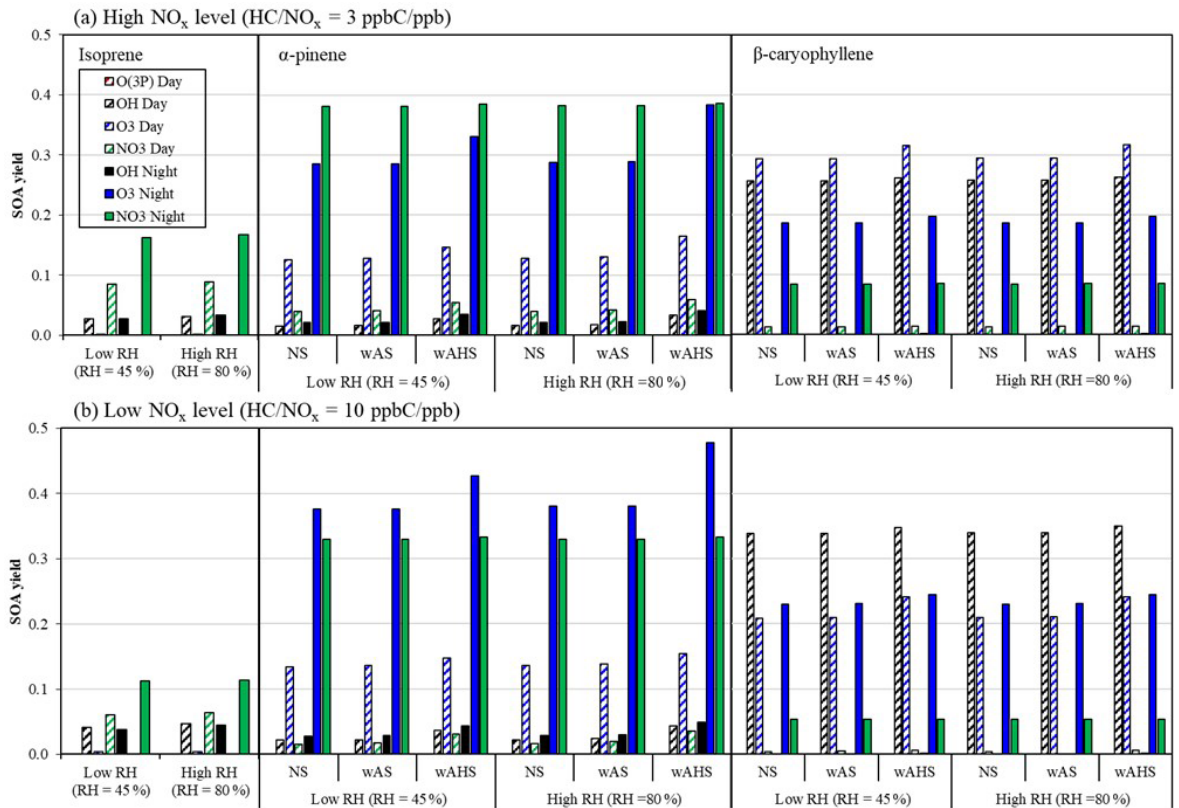
Figure 4. The simulated potential SOA yield from each oxidation path from the given HC consumption at a (a) high NO x level (HC / NO x = 3ppbCppb − 1 ) and (b) low NO x level (HC / NO x = 10ppbCppb − 1 ). The consumptions of biogenic HCs are set to 50ppb (138µgm − 3 ) for isoprene, 30ppb (162µgm − 3 ) for α -pinene, and 20ppb (167µgm − 3 ) for β -caryophyllene. The SOA formation was sim- ulated at 298K under two different RHs (45% and 80%) with 10µgm − 3 of OM 0 . For the α -pinene and β -caryophyllene, the SOA formed under three different seed conditions (NS, wAS, wAHS). For the inorganic seeded simulation, the seed concentration is 20µgm − 3 (dry